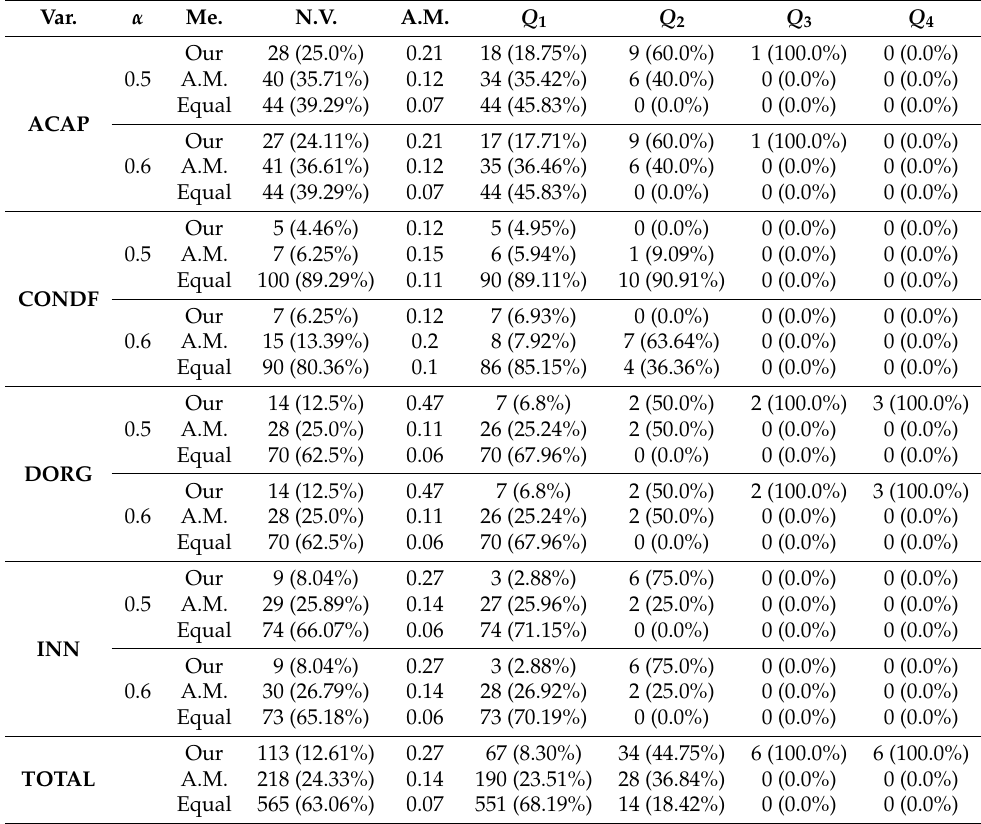
Table 12. Obtained results to variable DORG of the STraDyCaF